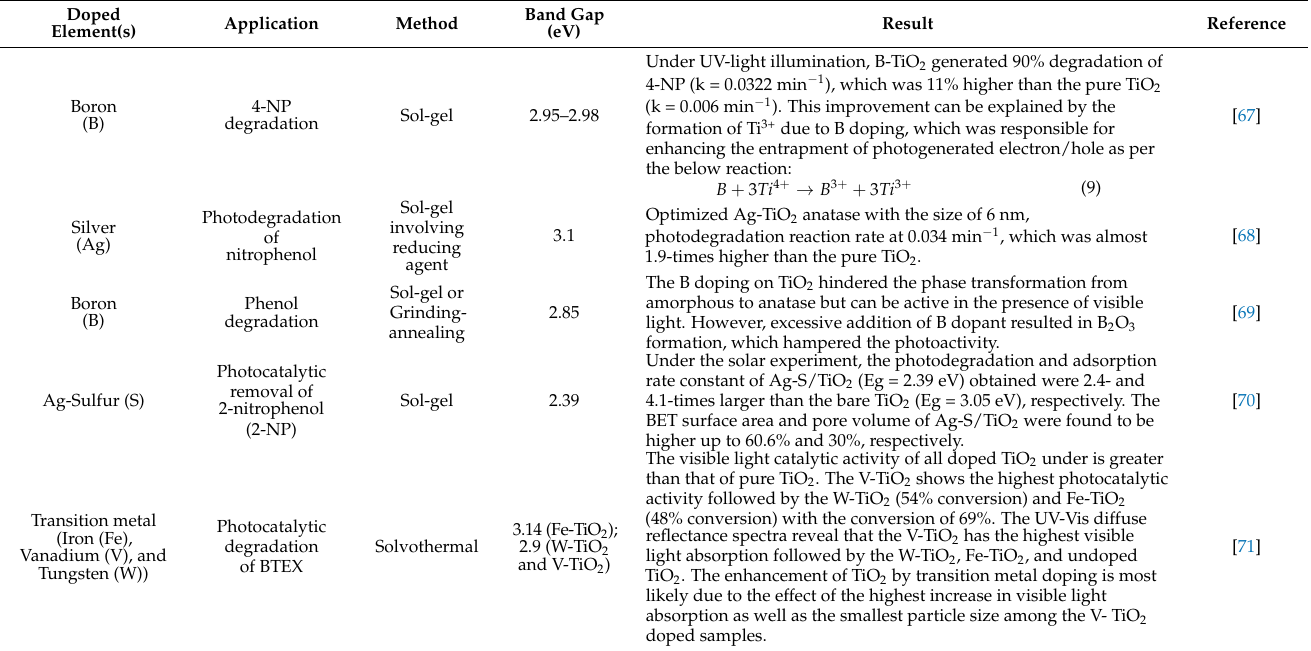
Table 3. Various preparations, applications, and results of the doped TiO 2